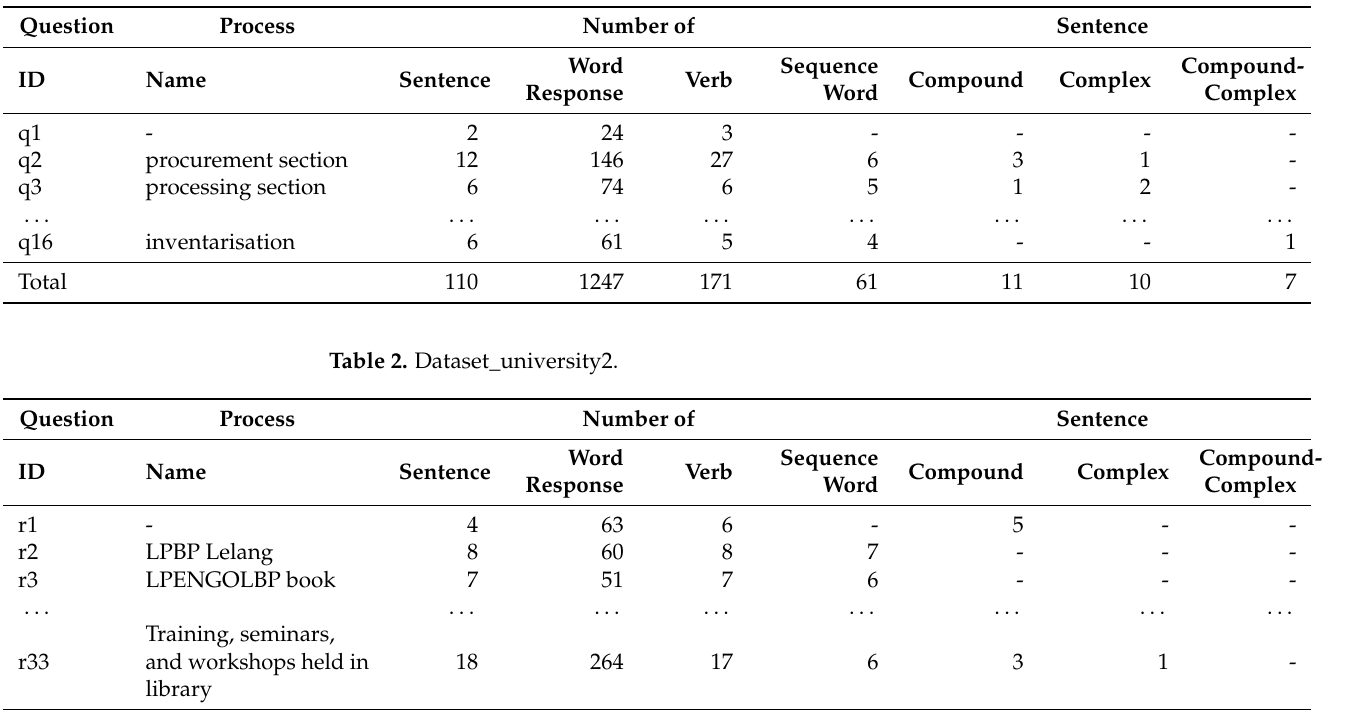
Table 1. Dataset_university1.